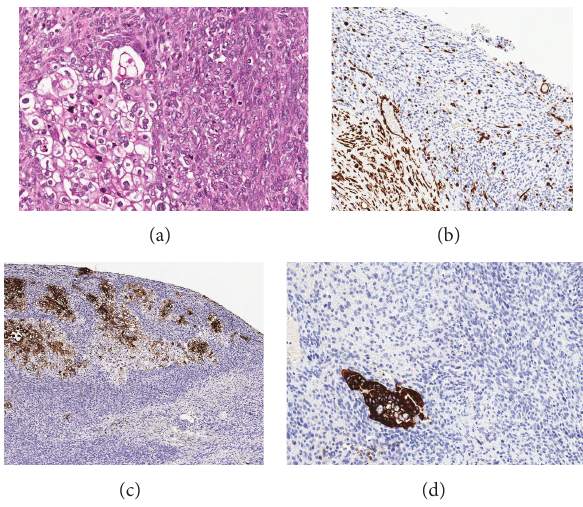
Figure 2: (a) Haematoxylin and eosin section showing malignant spindle cells with few clusters of malignant epithelioid cells. (b) Immunostaining showing focal positivity of the spindle cells for vimentin. (c) Immunostaining showing strong positivity of the epithelioid clear cells for CEA. (d) Immunostaining showing strong positivity of the epithelioid clear cells for CK7 at a